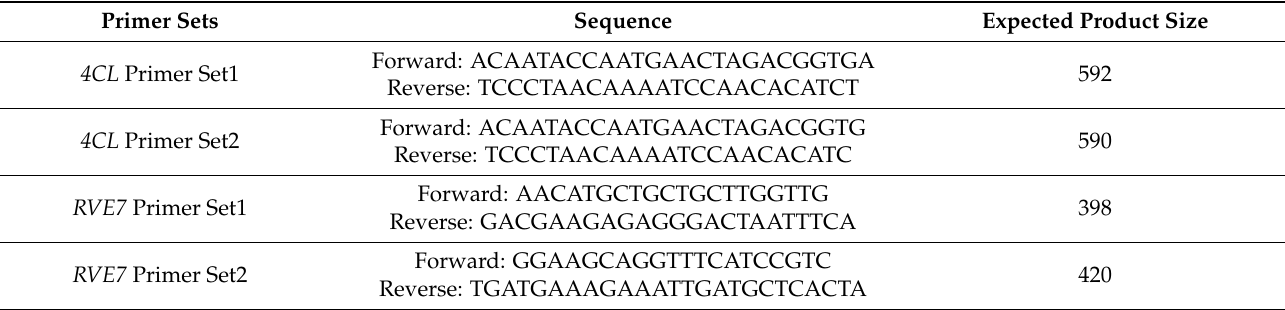
Table 3. The sequences of primer used for amplification of CRISPR target loci of 4CL and RVE7